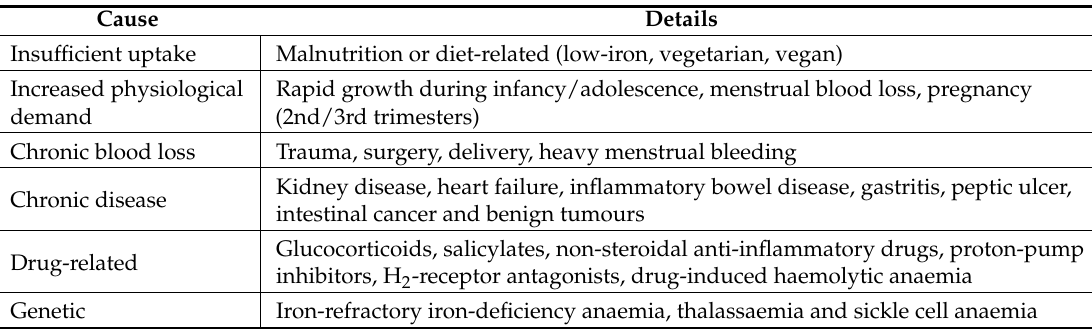
Table 1. Main causes of iron deficiency in the western world